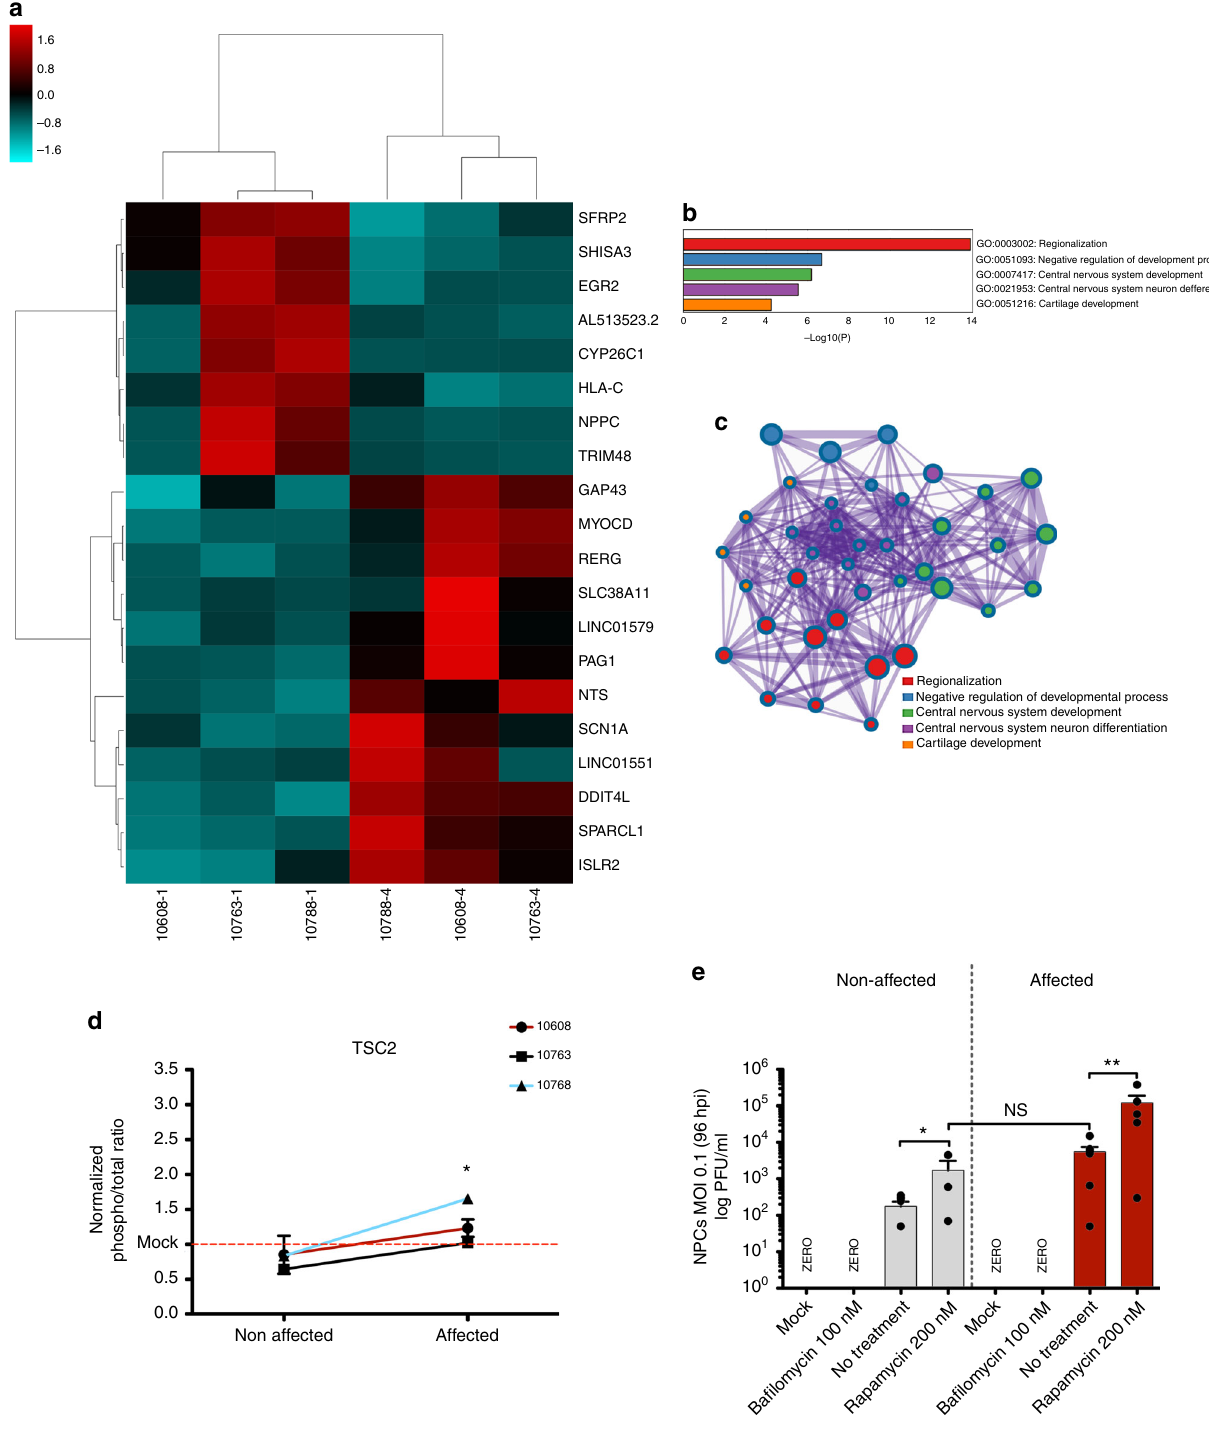
Fig. 4 NPC gene expression analyses by RNA-Seq in cultured cells prior to ZIKV infection (see also Supplementary Fig. 3). a Heatmap representation and clusterization of top 20 most signi fi cant DEGs ( p < 0.001; edgeR exact test) in NPCs in culture prior to ZIKV infection, in cells derived from non-affected (#10608-4, #10763-4, and #10788-4) and CZS-affected (#10608-1, #10763-1, and #10788-1) twins. Scale bar = Z score. b Enriched GO terms ( p value < 0.0001, cumulative hypergeometric distribution). c Enriched GO terms interaction network. The thickness of the lines connecting the circles indicates the number of interactions between genes included in each GO term sub-category represented by each circle. d TSC2 activity analysis by multiplex array (#10608, #10763, and #10788 twins; mean ± SEM; * p < 0.05; Student's t test). e PFU/mL measurement in infected NPCs after ba fi lomycin/rapamycin treatment (#10608, #10763, and #10788 twins; mean ± SEM; * p < 0.05; ** p < 0.01; NS = not signi fi cant; one-way ANOVA with Tukey ’ s post hoc